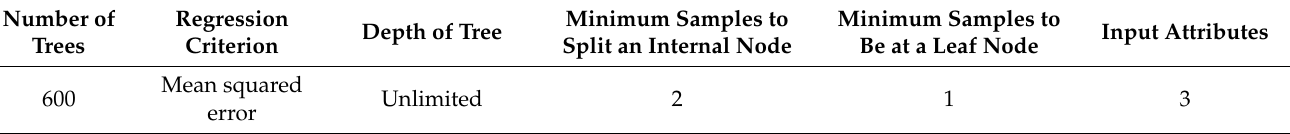
Table 3. Process parameters for random forest algorithm calculations.